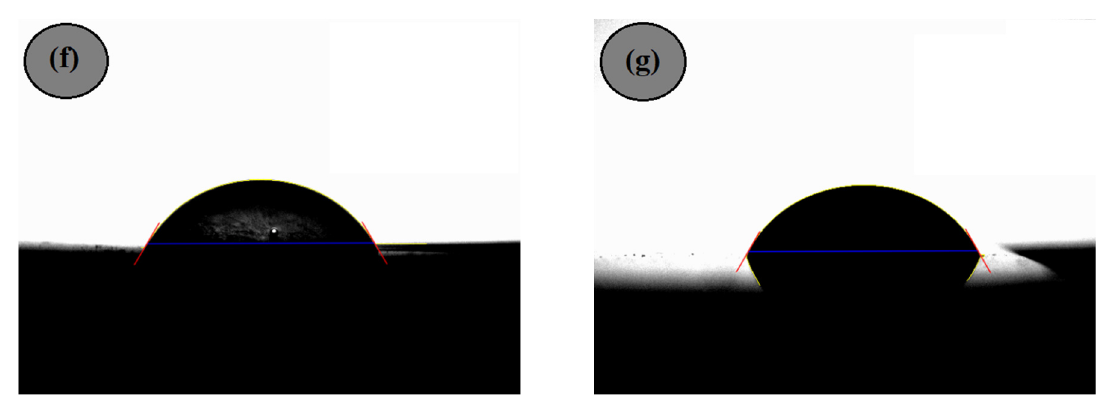
Figure 18. Mean contact angle at 200 s for ( a ) PA6; ( b ) PA6/ABS-MA (5%); ( c ) PA6/ABS-MA (7.5%); ( d ) PA6/ABS-MA (10%); ( e ) PA6/ABS (5%); ( f ) PA6/ABS (7.5%); ( g ) PA6/ABS (10%). PA6 had the smallest contact angle (46.5°), suggesting greater water affinity, i.e., PA6/ABS-MA blends generally have contact angles higher than PA6/ABS